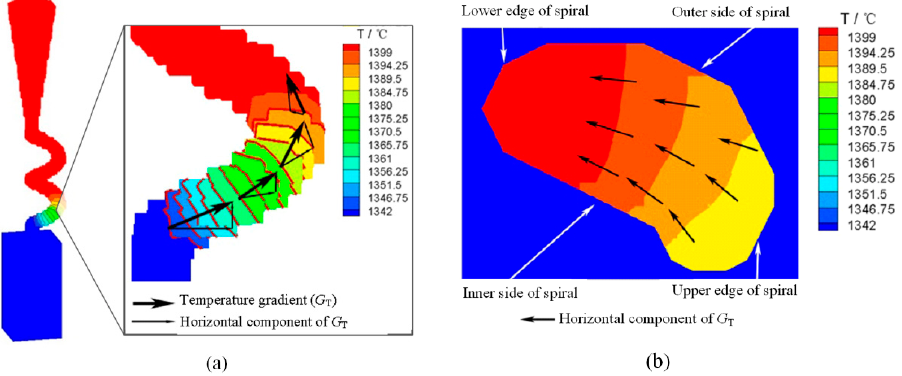
Figure 9. Simulation result of spiral temperature field distribution: ( a ) local temperature distribution of selector and ( b ) temperature gradient horizontal component in cross section.